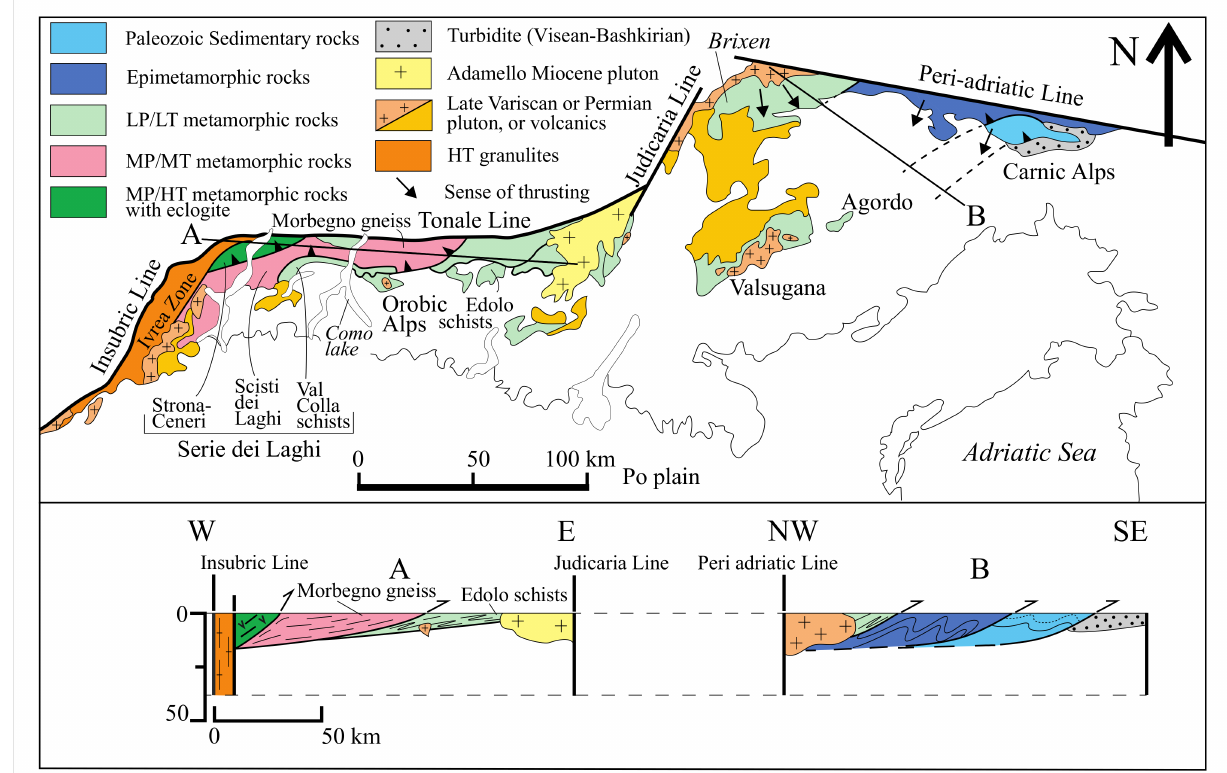
Figure 8. Structural map of the South Alpine Domain (redrawn after [96,102,106,112]). Synthetic cross-section from the Ivrea zone to the Carnic Alps along the lines A and B shown in the